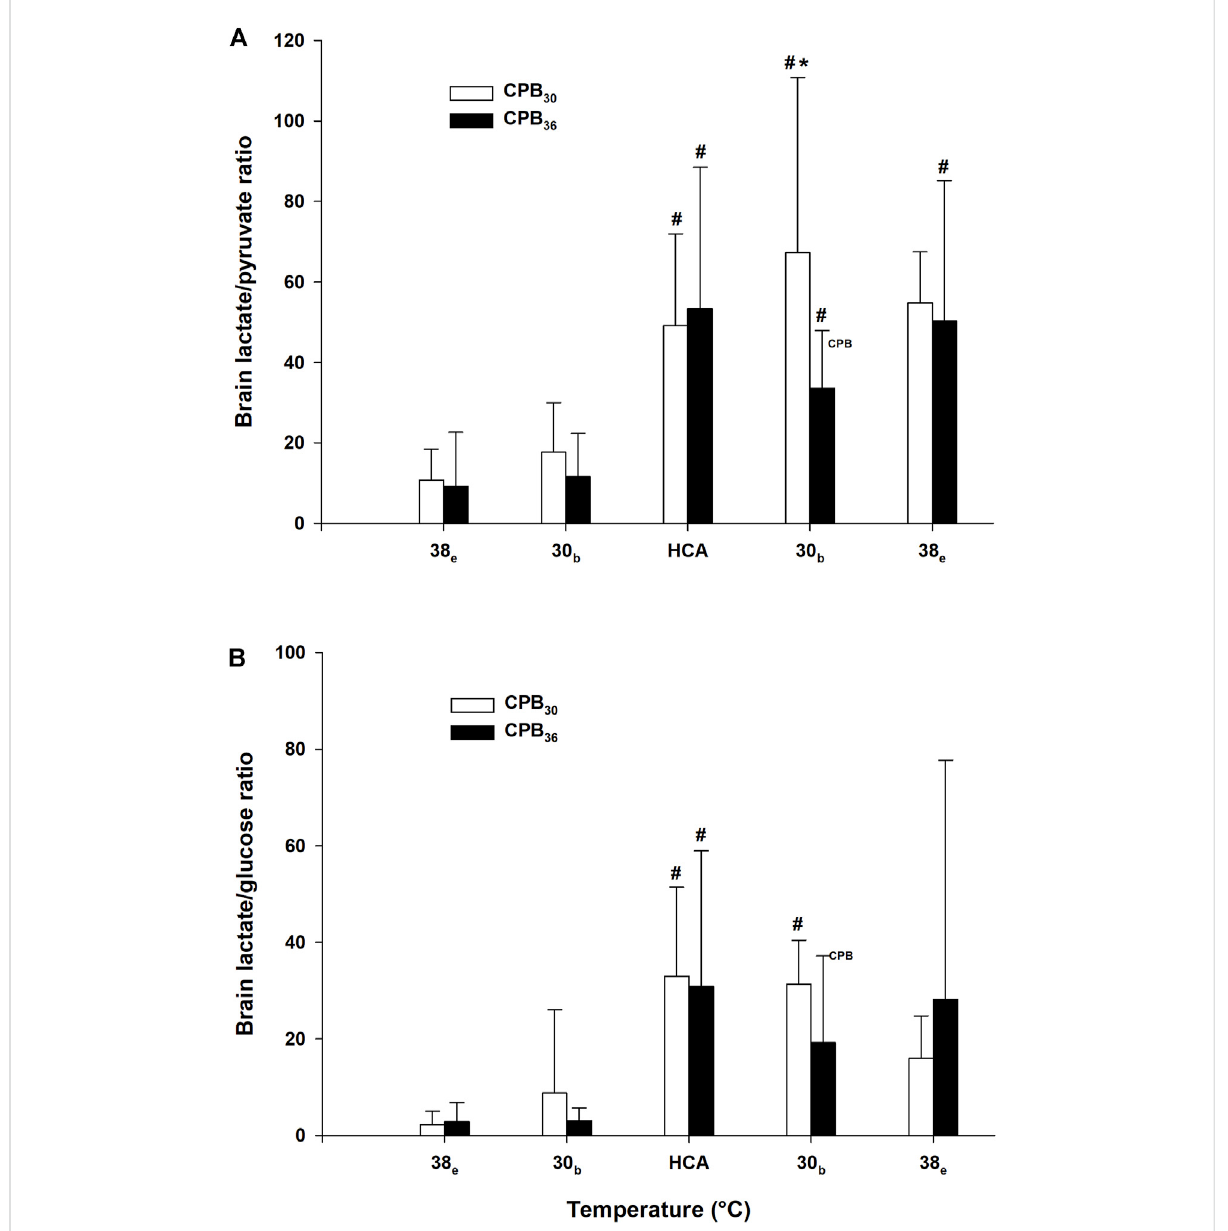
FIGURE 7 Brainmicrodialysateanalyses(cont.). (A) :brainlactate/pyruvateratio, (B) :brainlactate/glucoseratio.Temperaturemeasuredin:e – esophagus; b – bladder. Data presented as mean and SD. # p < 0.05 vs. intragroup baseline; * p < 0.05 vs. corresponding value in another group; CPB – variables measured during ongoing